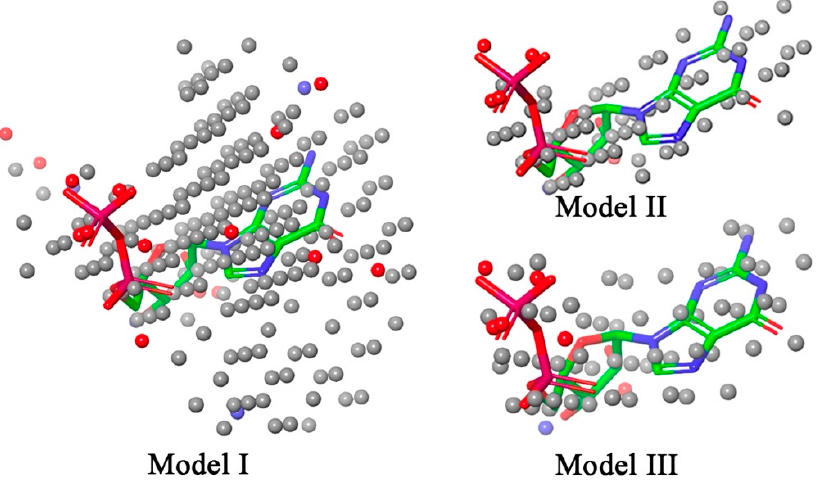
Figure 2. The negative image-based models developed for the receptor of hRRM1. The GDP is mapped in each generated NIB model. Table 1. Experimental inhibitory concentration and ShaEP score based on three models for known hRRM1